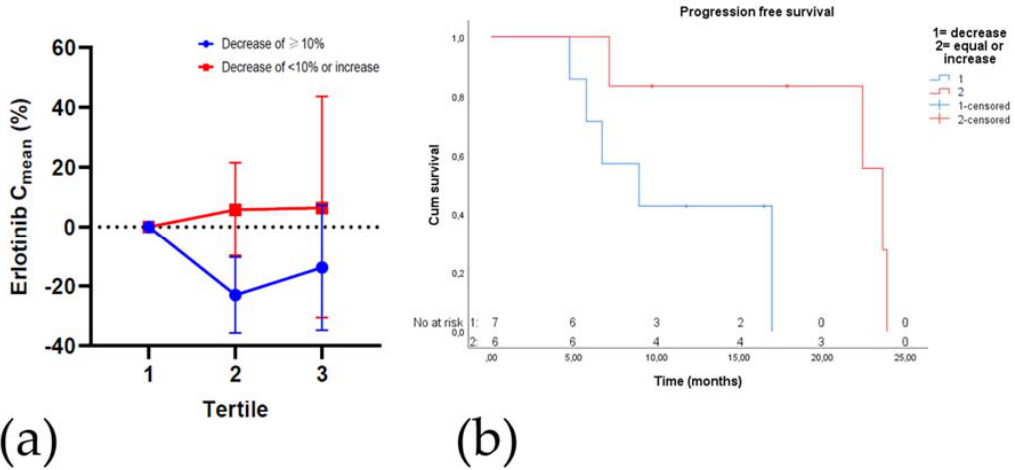
Figure 4. ( a ) Relative change in erlotinib C mean during treatment. Treatment period is divided in tertiles; ( b ) progression-free survival based on the erlotinib C mean in the second tertile compared to the first tertile. The first (red-line) group has a decrease of less than 10% or an increase in C mean . The second (blue-line) group has a decrease of at least 10% in erlotinib C mean . C mean = mean plasma concentration.